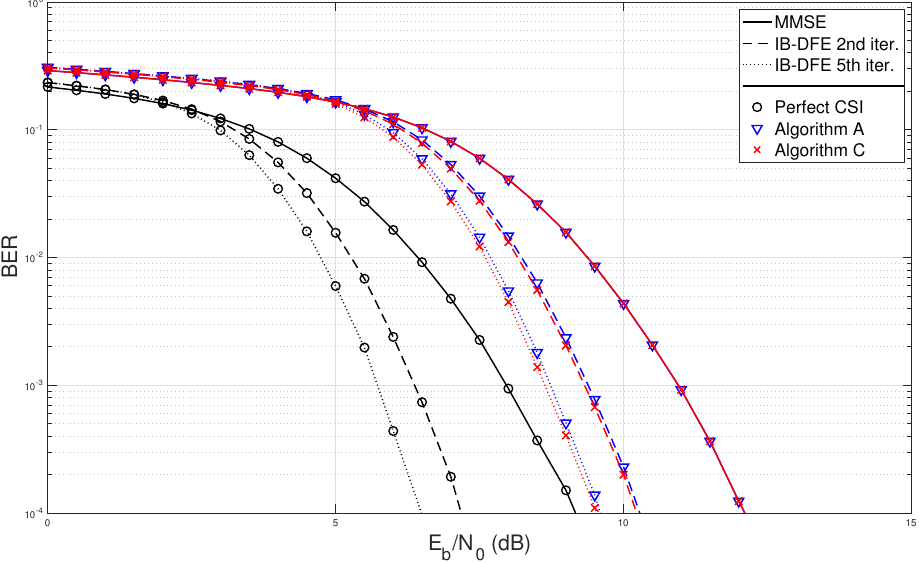
Figure 7. BER results for TIBWB–OFDM with IB–DFE over a dispersive channel employing Algorithm C for a ZC preamble sequence with 3 dB higher average power than the data